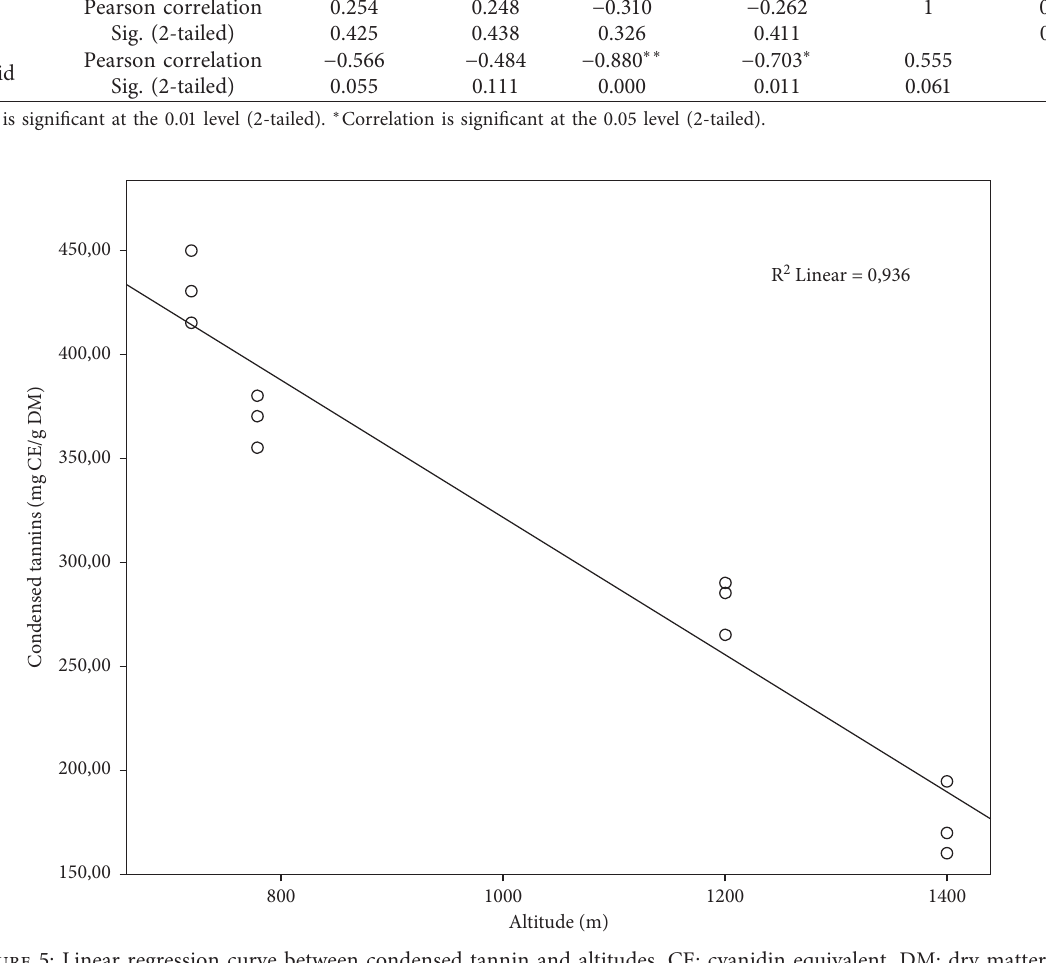
Figure 5: Linear regression curve between condensed tannin and altitudes. CE: cyanidin equivalent. DM: dry